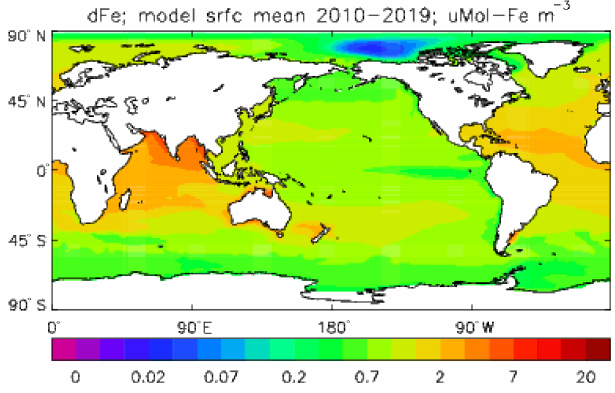
Figure 27. Surface dissolved iron, averaged over model years 2010–2019 (µmolFem − 3